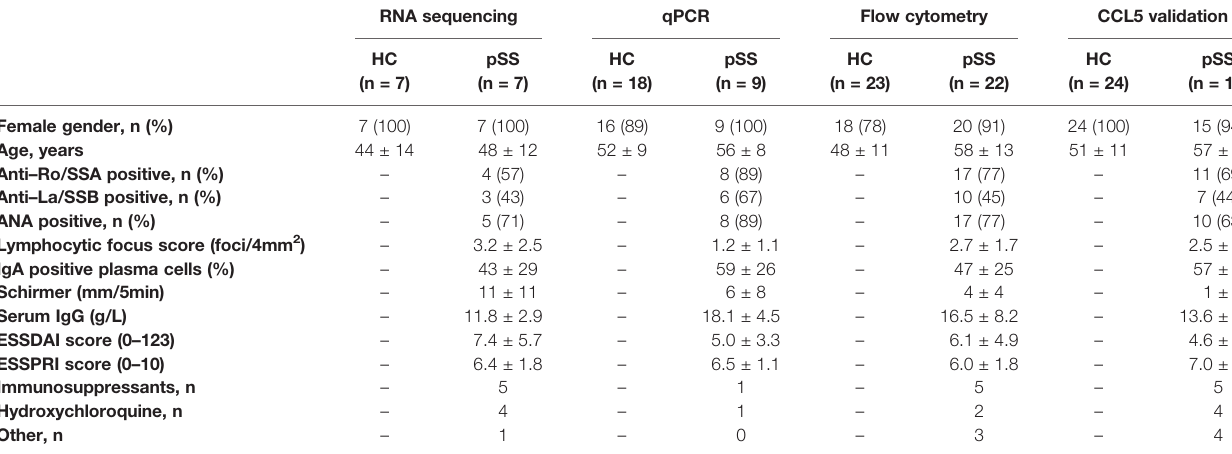
TABLE 1 | Patients ’